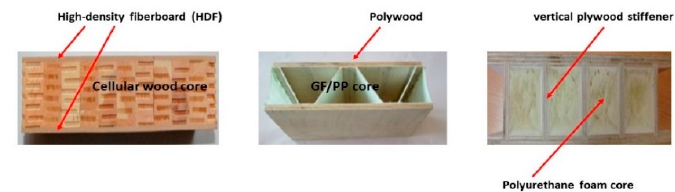
Figure 12. Studied composite panels by Labans et al. Adapted from [55] .